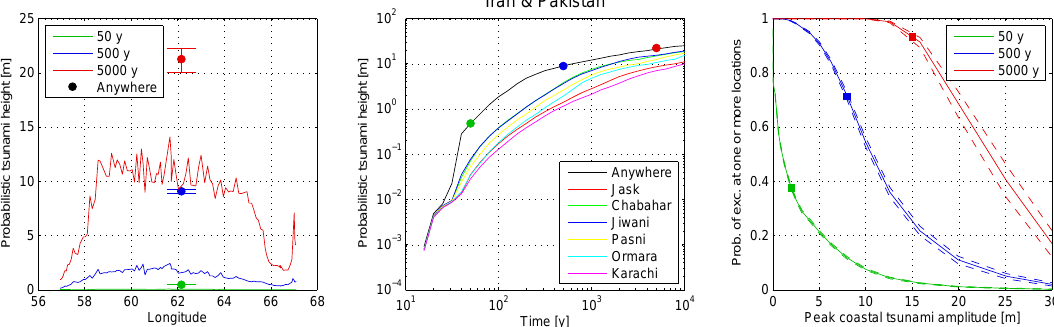
Figure 3. Left: probabilistic tsunami height (PTH) for Iran and Pakistan along Longitude (colored lines) and for the whole coast at once (circles with 15th and 85th percentile bars). Center: PTH as function of time for selected cities (color) and the coastline as whole (black). Right: probability of exceedance (POE) as function of peak coastal tsunami amplitude (PCTA) for different time periods. Dashed: 15th/85th percentiles.